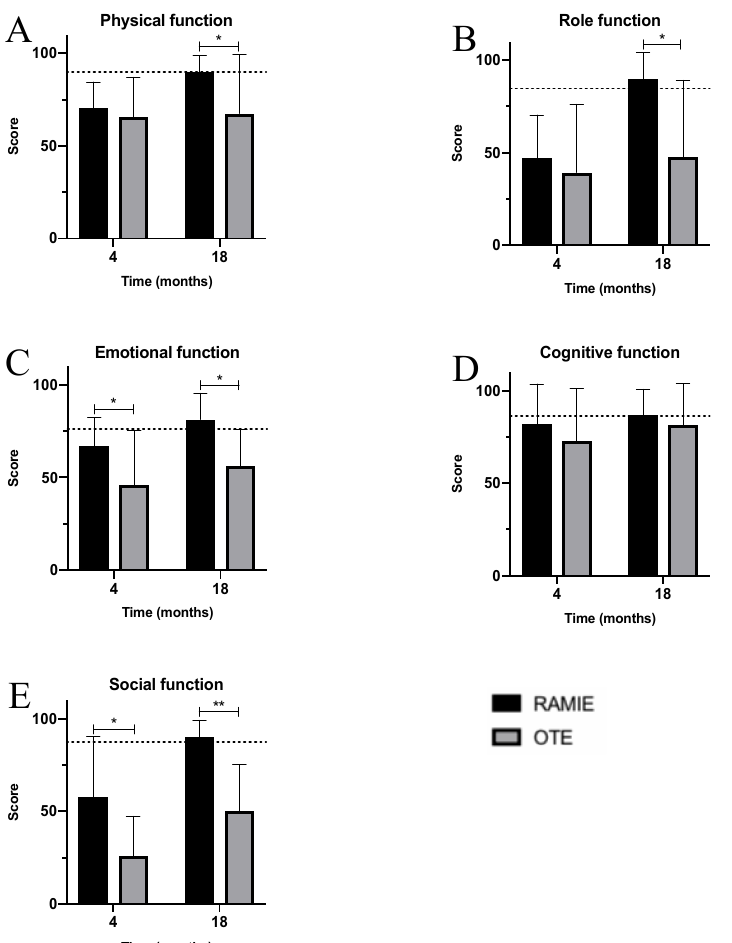
Figure 6. Function in the PSM analysis stratified by cohorts—RAMIE (black) vs. OTE (grey). ( A ) Physical function; ( B ) role function; ( C ) emotional function; ( D ) cognitive function; and ( E ) social function. RAMIE: robot ‐ assisted minimally ‐ invasive esophagectomy; OTE: open transthoracic esophagectomy.